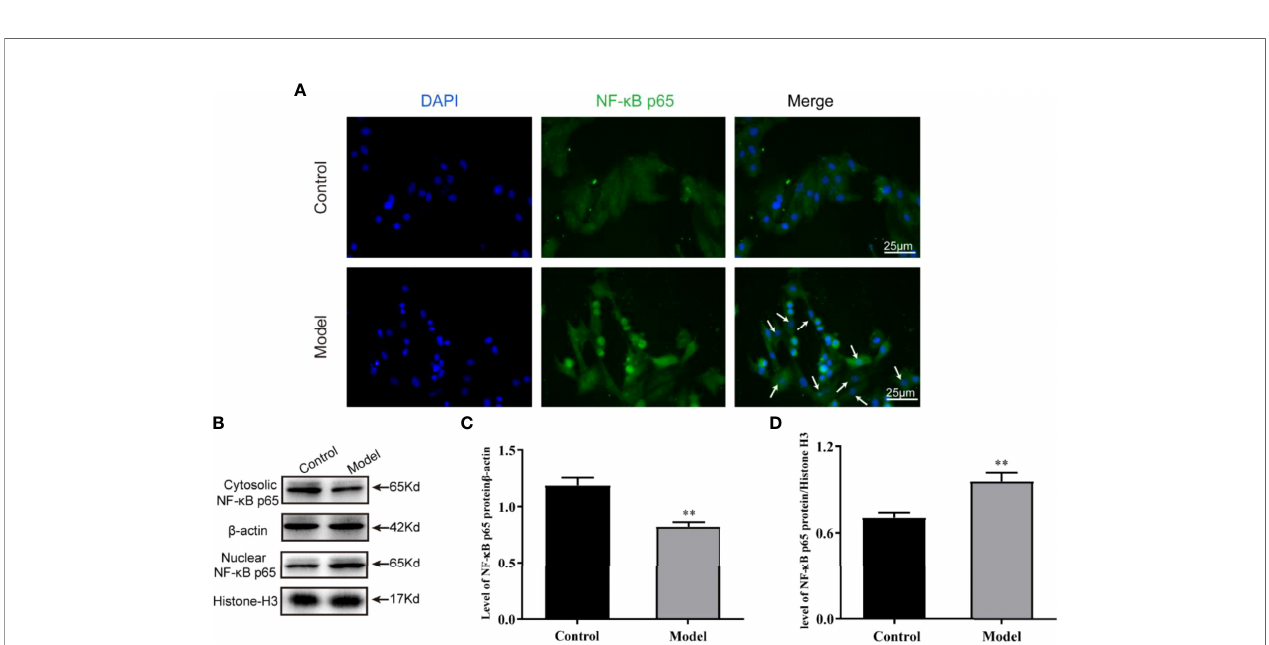
FIGURE 3 | Nuclear translocation of NF- k B p65 occurred under OGD induction in H9c2 cells. (A) The protein expression levels of the NF- k B p65 (green color) in cardiomyocyte nuclear by immuno fl uorescence, and the slides were counterstained with DAPI (blue). Representative images of western blotting (B) and quantitative data (C, D) of the protein levels of NF- k B p65 in the nuclear and cytosolic. One-way ANOVA test was used for statistical analyses. Bars represent means ± SD; **P <0.01 . ns, no signi fi